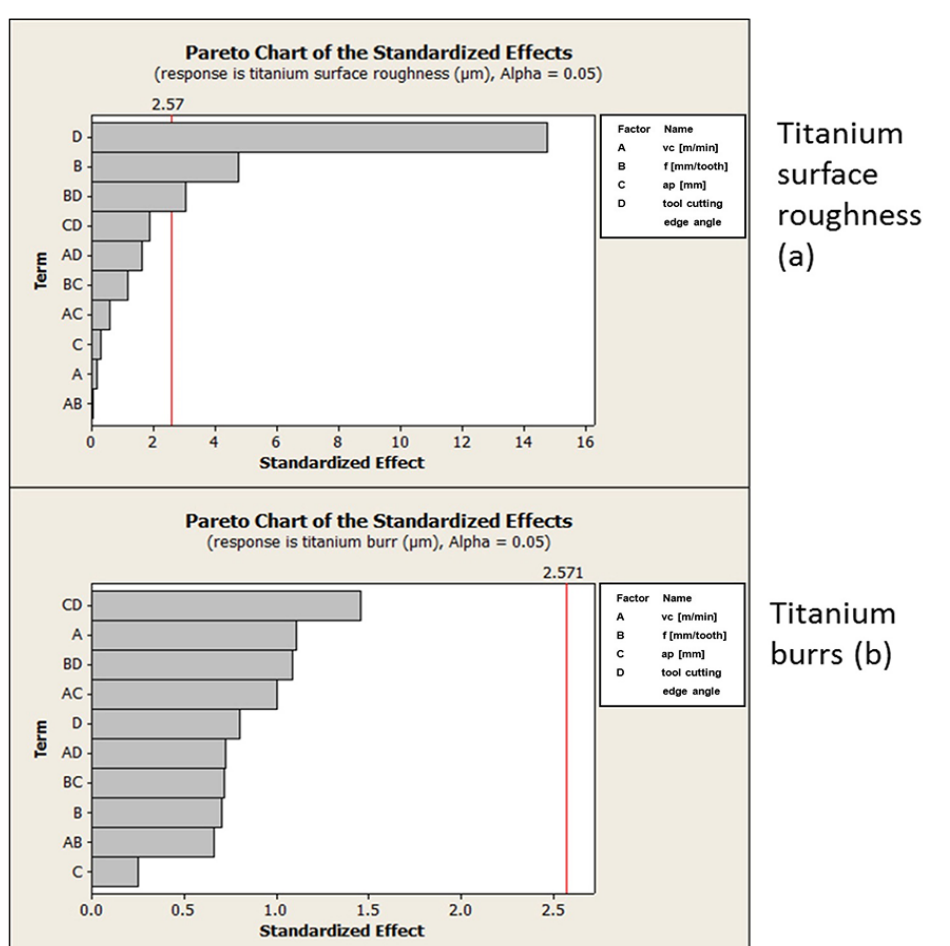
Figure 6. Pareto charts for titanium burrs and surface roughness